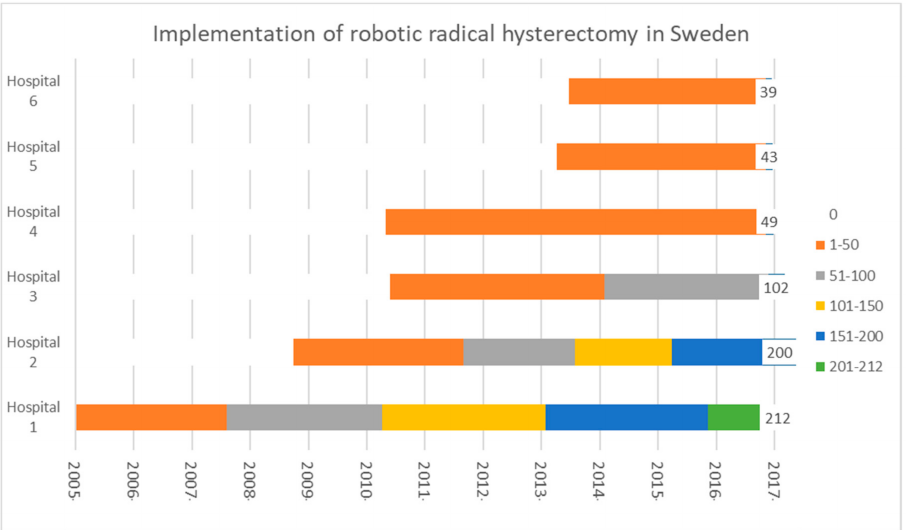
Figure 1. Implementation and number of robotic radical hysterectomies (RRHs) for stage IA2-IB1 (FIGO 2009) squamous, adenocarcinoma or adenosquamous cervical cancer performed per hospital in Sweden from the first RRH in December 2005 until June 2017.